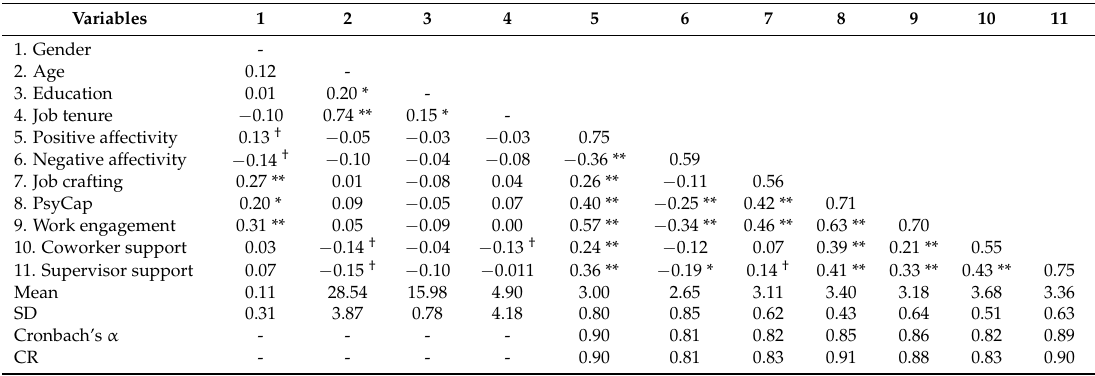
Table 1. Descriptive statistics of